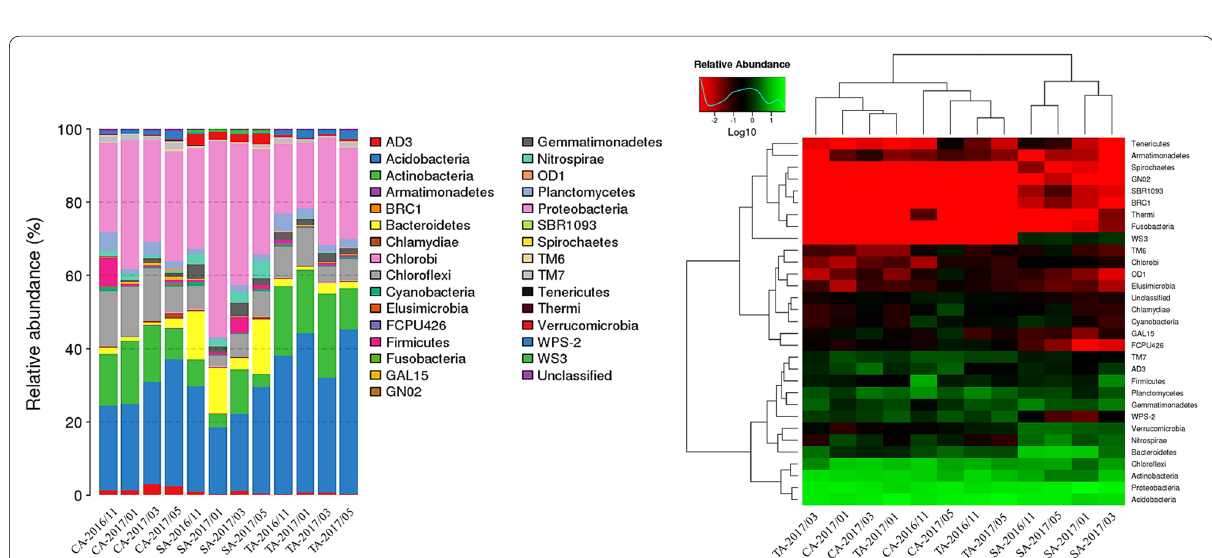
Fig. 6 Distribution and heat map of OTUs at the phylum level obtained from CA, TA, and SA soils between November 2016 and May 2017. The taxonomic composition distribution and heat map were implemented by the R